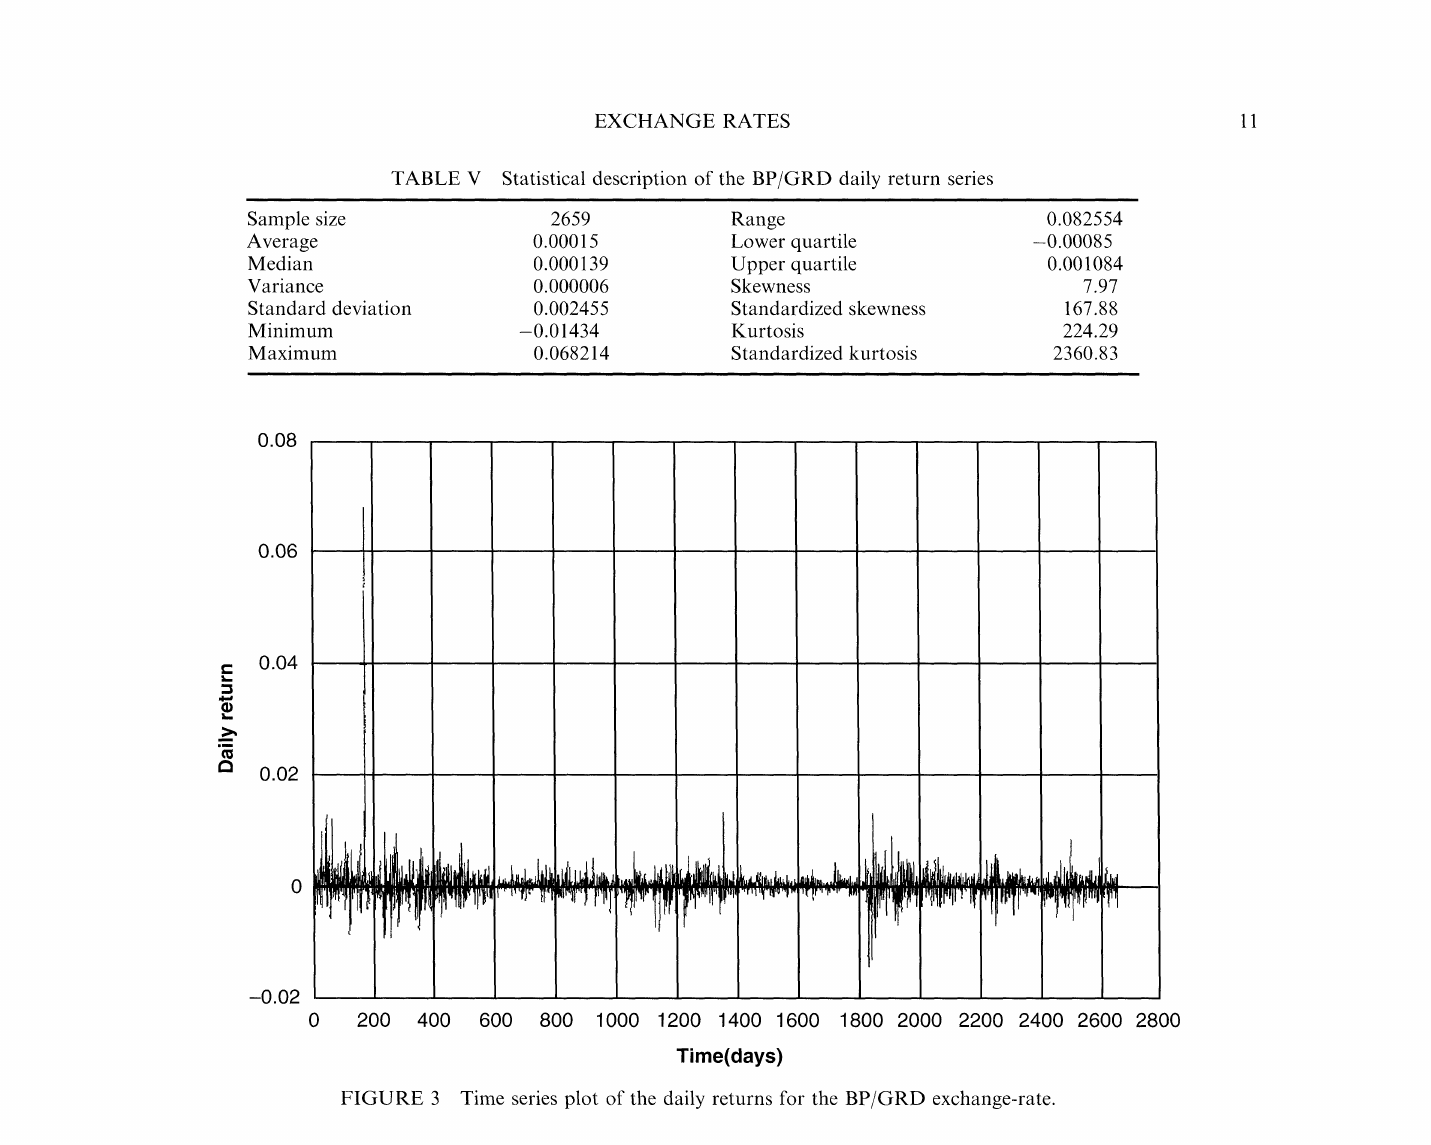
FIGURE 3 Time series plot of the daily returns for the BP/GRD